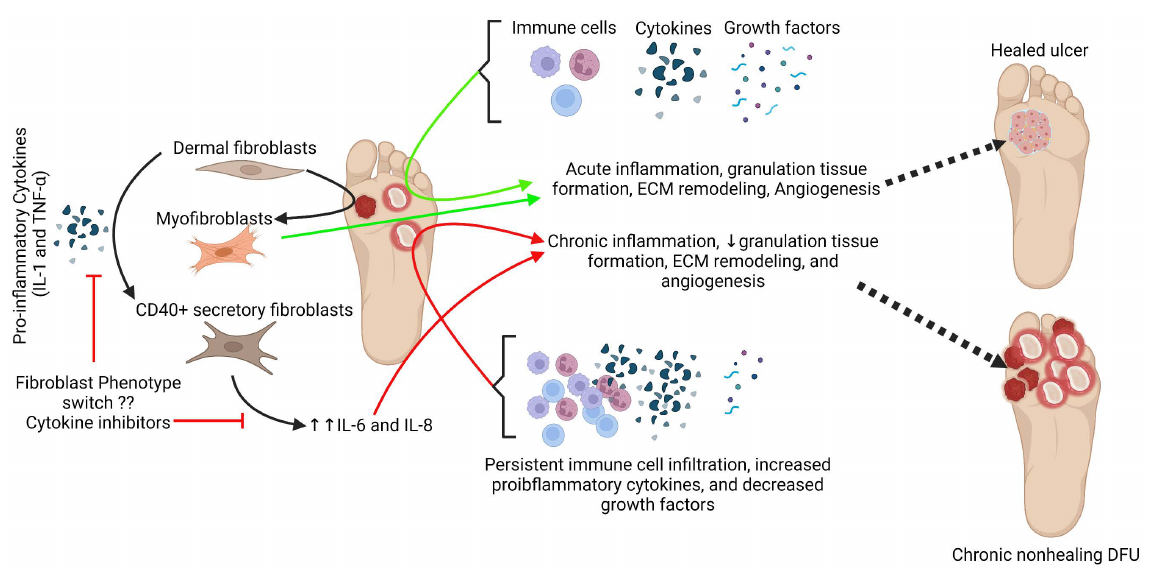
Figure 8. Schematics showing the pathogenesis of chronic inflammation-mediated impaired wound healing and phenotypic change of fibroblasts in an inflammatory environment. Interleukin (IL), tumor necrosis factor (TNF), and extracellular matrix